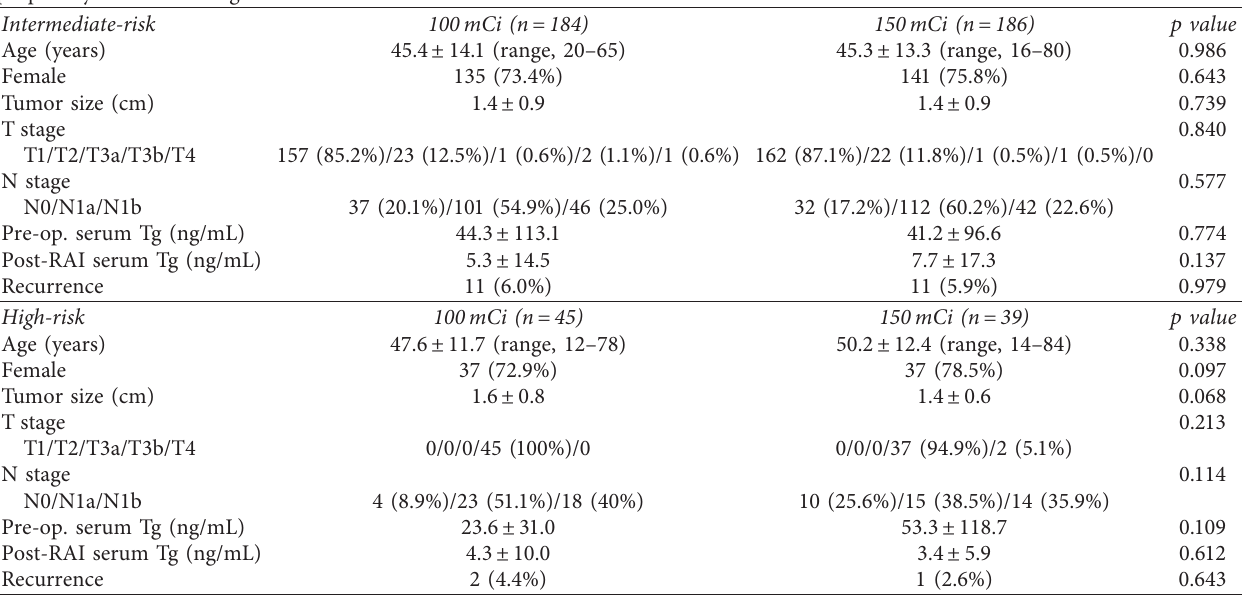
Figure 4: Disease-free survival curves according to lymph node ratio after propensity score matching (cut-off, 0.22; p � 0 . Table 5: Subgroup analysis between intermediate- (100mCi) and high-dose (150mCi) groups according to the ATA risk stratification after propensity score matching.